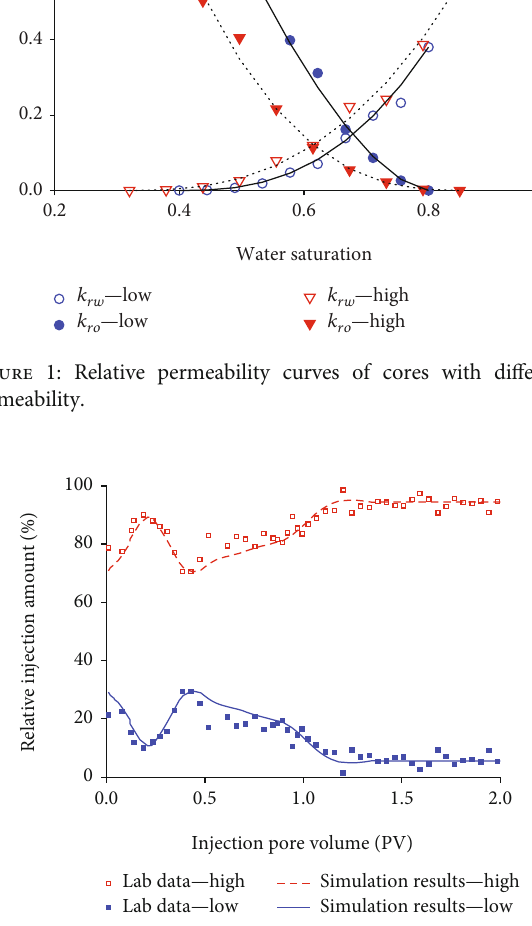
Figure 2: Comparison of injection conformance between experiment data and model